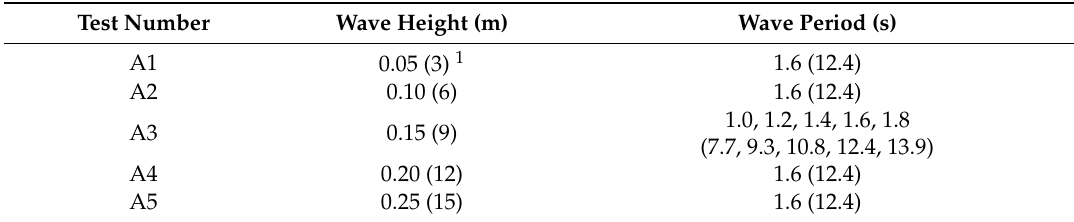
Table 4. Regular waves for the physical model experiment.